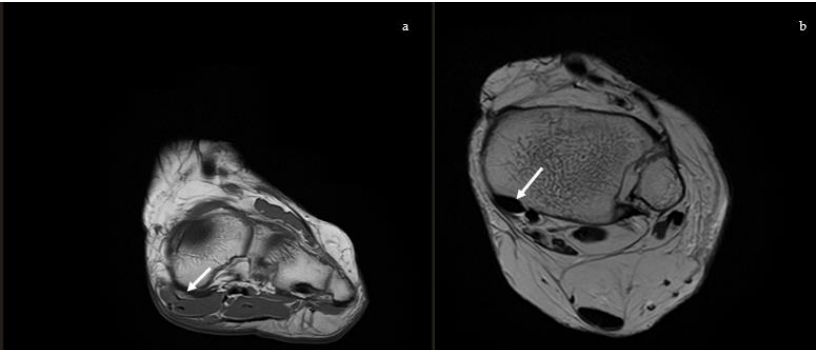
Figure 10. Magnetic Resonance Imaging. ( a ) Coronal T1: soft tissue involvement of the posterior tibial tendon, ( b ) Axial T2: superomedial fibers of the spring ligament (white arrow).